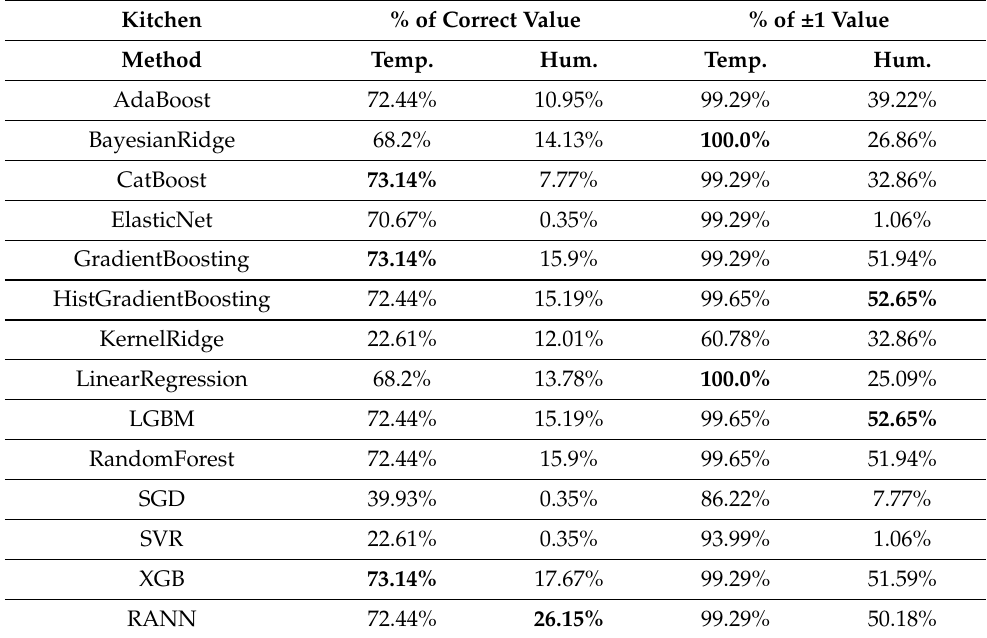
Table 5. Evaluation of algorithms for the measurements bedroom-kitchen.